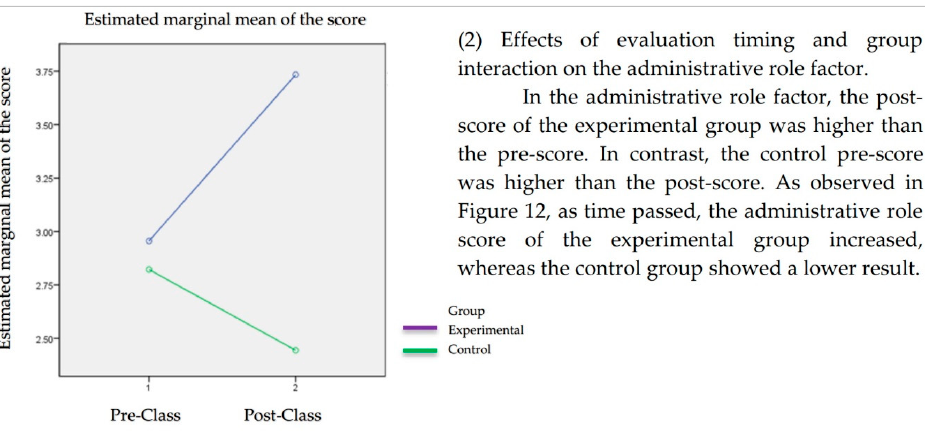
Figure 11. Effect of timing and group interaction on Autonomy.